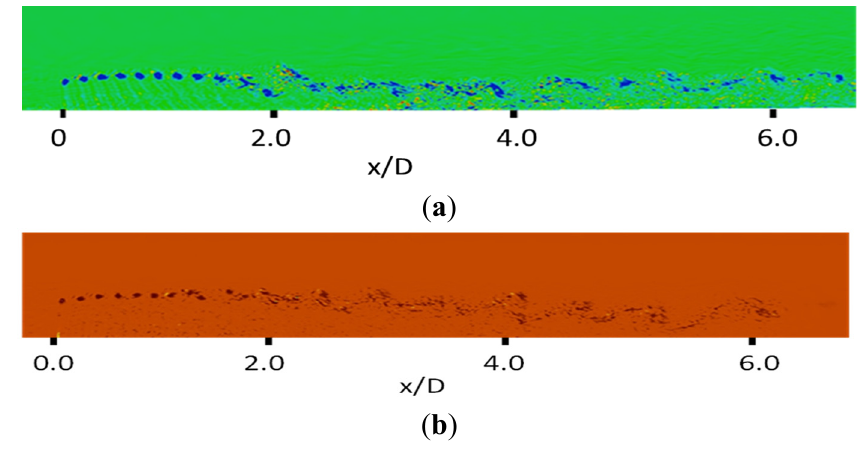
Figure 12. Spanwise slice of isocontours of the vorticity field of the upper tip-vortex has been isolated for WT in ( a ) low-stable; ( b ) moderately-stable ABL regime. The distinct upper-tip vortices merge to form vortex blobs and they evolve downstream. The contour levels correspond to (0.5–2.0 1/s).